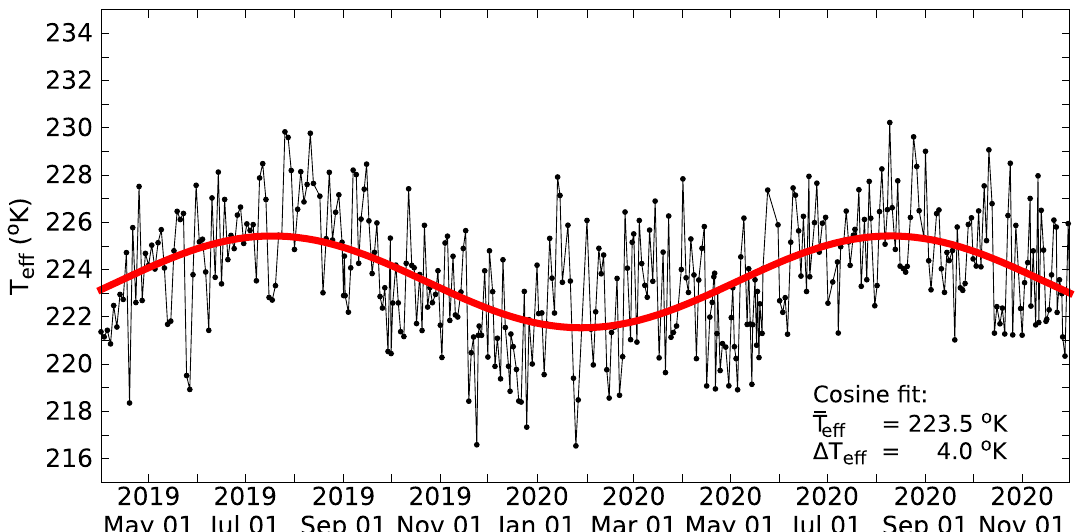
Figure 9. The effective temperatures are shown for the data collection period. The T eff values were calculated using the balloon-borne measurements performed above the Kagoshima Bay 62 . The cosine fit shows an average ◦ ◦ seasonal variation of 4 K around the average value of 223.5